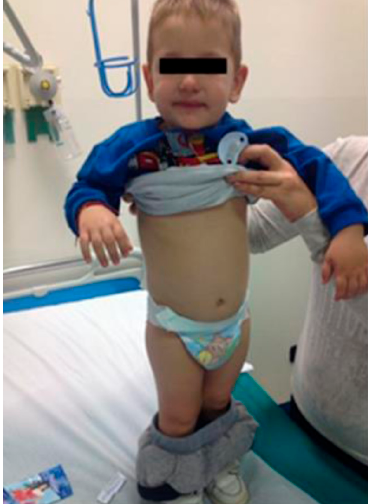
Figure 2. At the follow-up after three months of a gluten-free diet, at 27-months of age, the child was able to walk independently, was no longer irritable, and had no gastrointestinal symptoms; his skin appeared normally hydrated, and he had well represented adipose tissue and a plain abdomen.